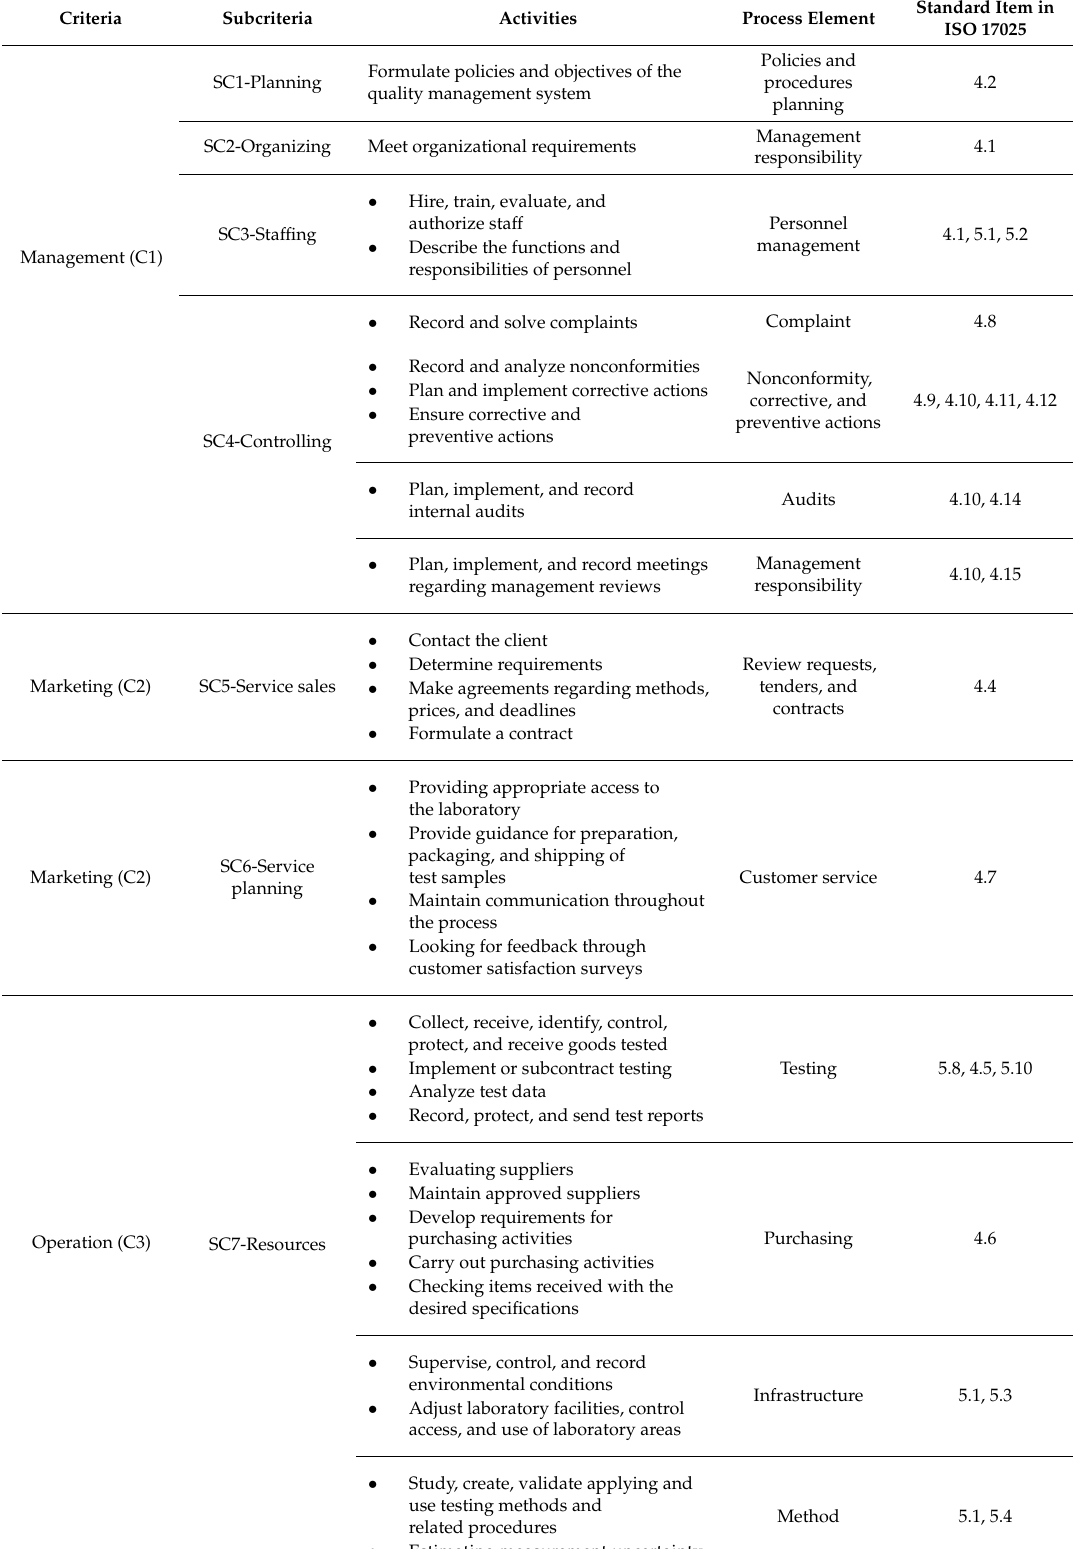
Table 1. Organizational audit factors and laboratory’s testing service activities distribution.